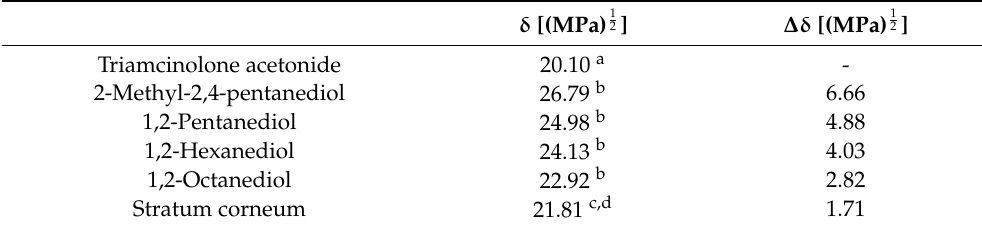
Table 2. Solubility parameters ( δ ) of the substances and differences of solubility parameters between the alkanediols, stratum corneum and triamcinolone acetonide ( ∆ δ